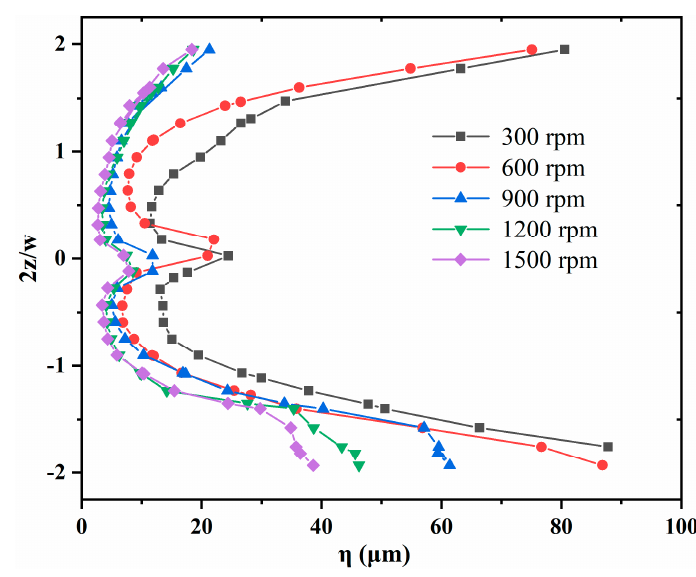
Figure 8. The Kolmogorov scale ( η ) under different rotation speeds.